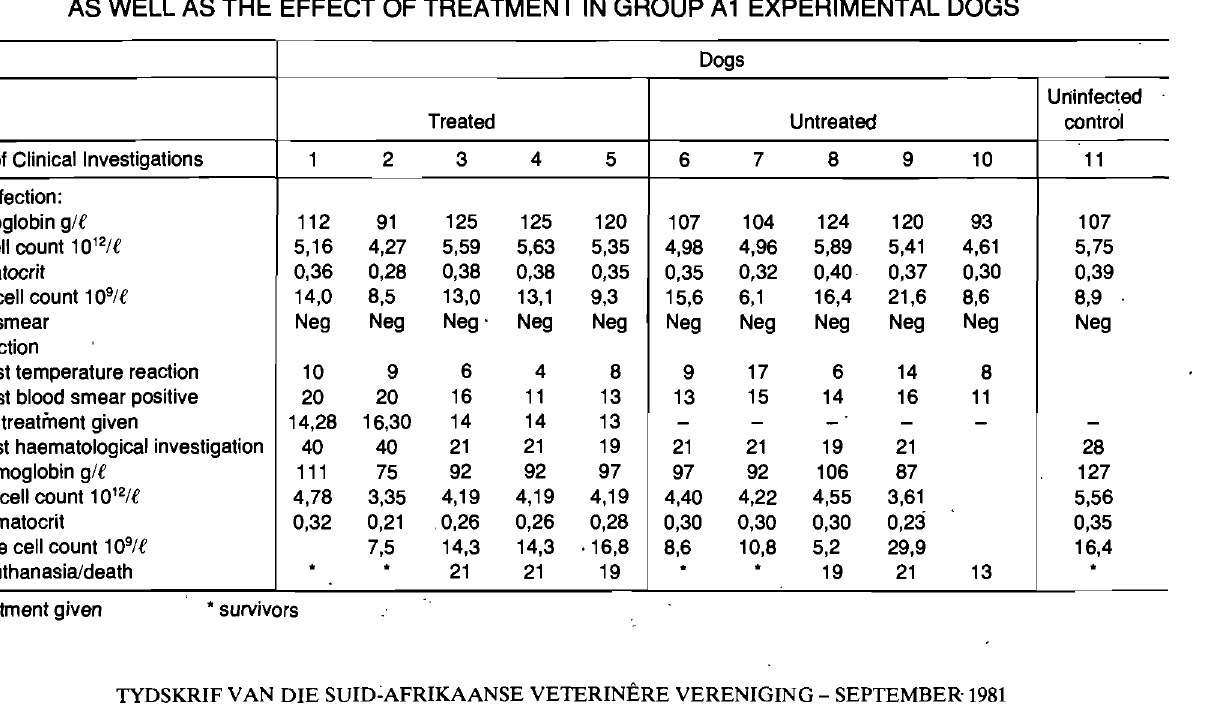
Table 1: RESULTS OF THE HAEMATOLOGICAL INVESTIGATIONS BEFORE AND AFTER INFECTION AS WELL AS THE EFFECT OF TREATMENT IN GROUP A1 EXPERIMENTAL DOGS Dogs Urtinfected Treated